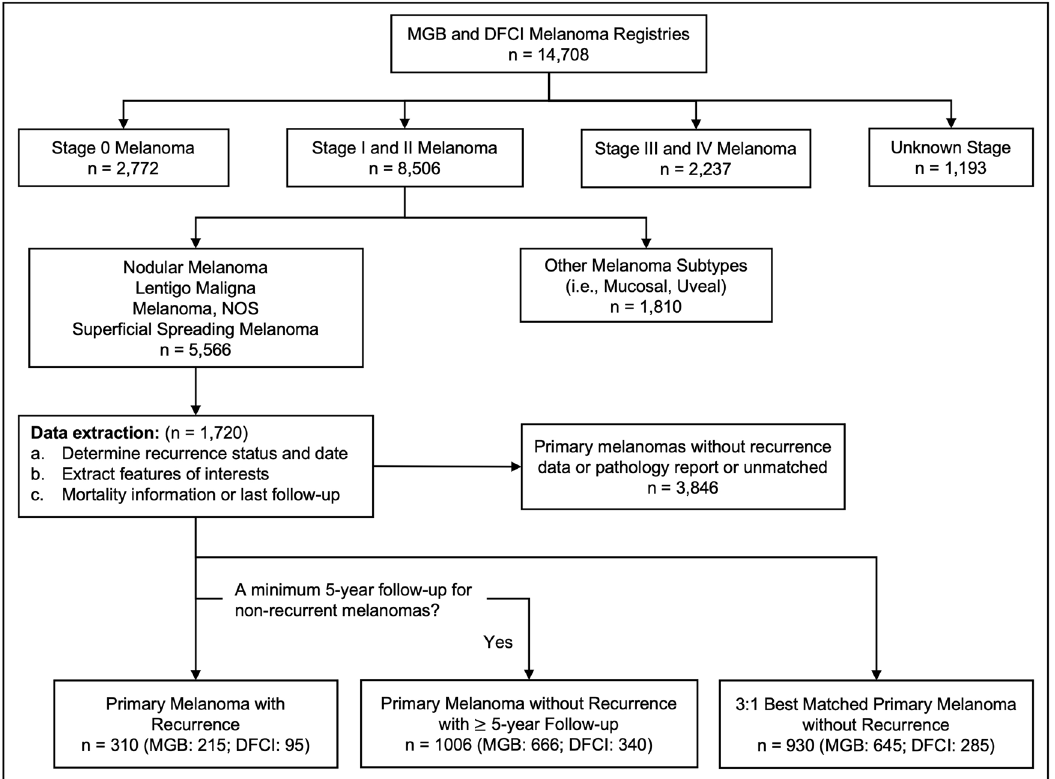
Fig. 1 MGB and DFCI primary melanoma registry design and cohort de fi nitions. Non-recurrent melanomas were categorized into two groups: one group with a minimum of 5-year follow-up duration; another group 3:1 best matched to the recurrent melanomas in terms of follow-up duration. The fi rst group was compared to recurrent melanomas in the binary recurrence classi fi cation tasks. The second group was compared to recurrent melanomas in the time-toevent recurrence prediction